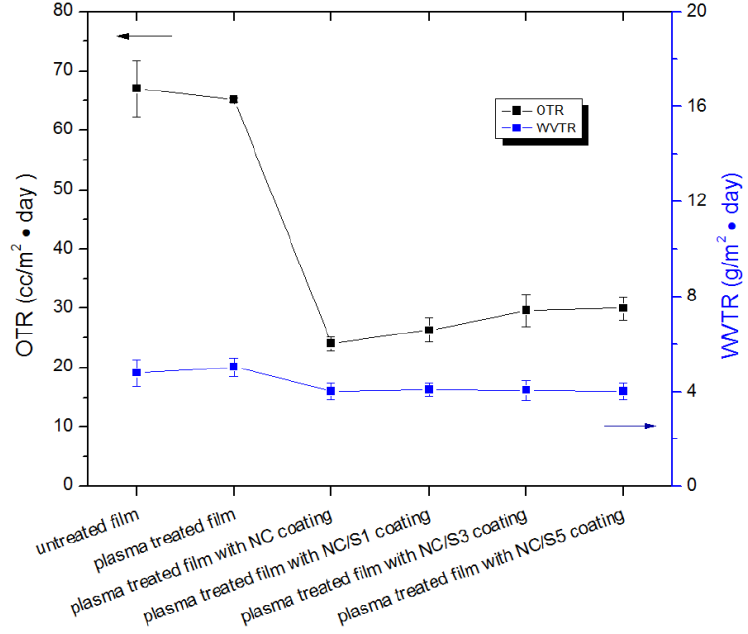
Figure 4. Oxygen transmission rate and water vapor transmission rate of BOPP/LDPE films under different surface process.